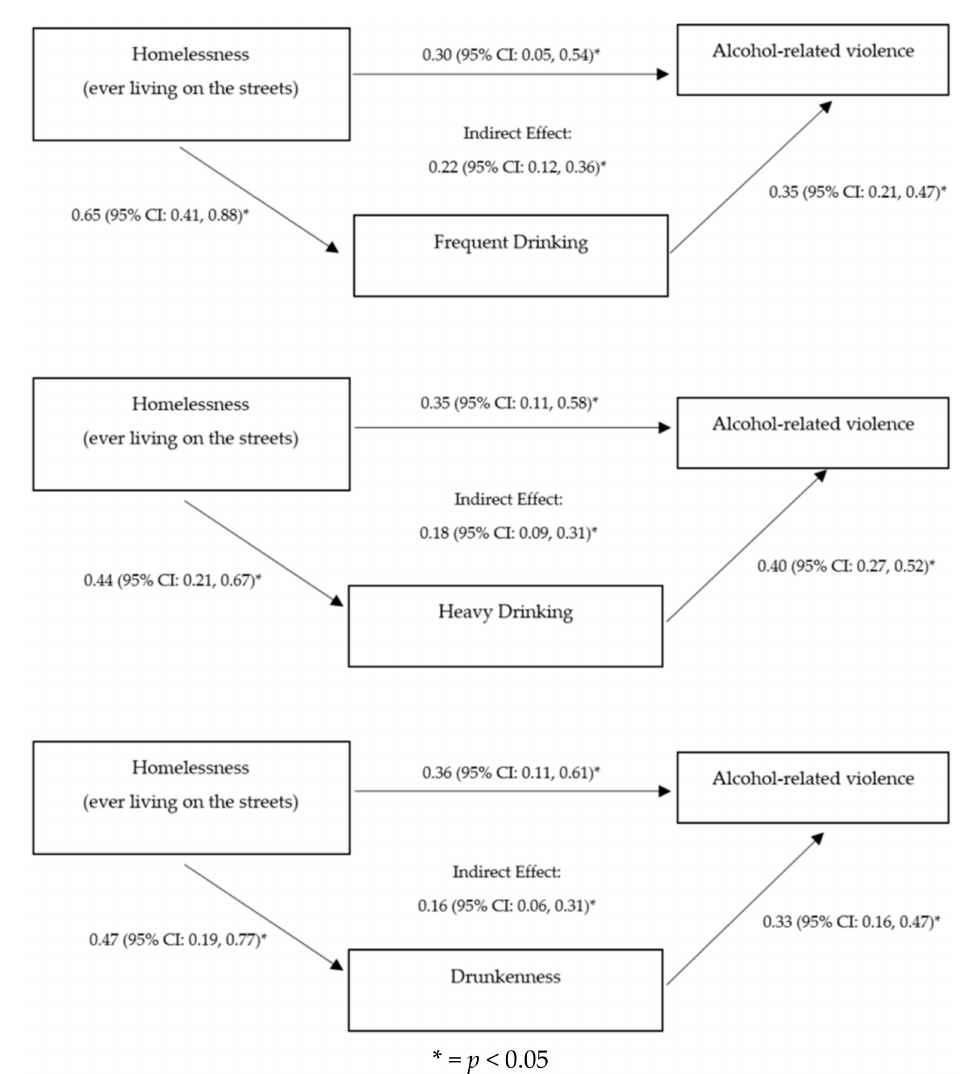
Figure 1. Mediation models for homelessness, problem drinking/risky drinking patterns, and alcohol-related violence among youth living in the slums of Kampala who reported alcohol consumption in the past year ( n =